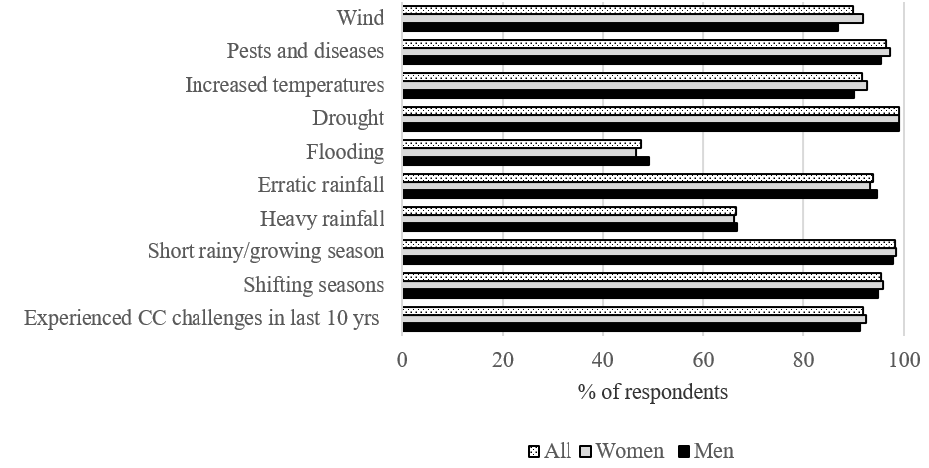
Figure 2. Farmers’ perceived climate-change related challenges experienced in the last 10 years.